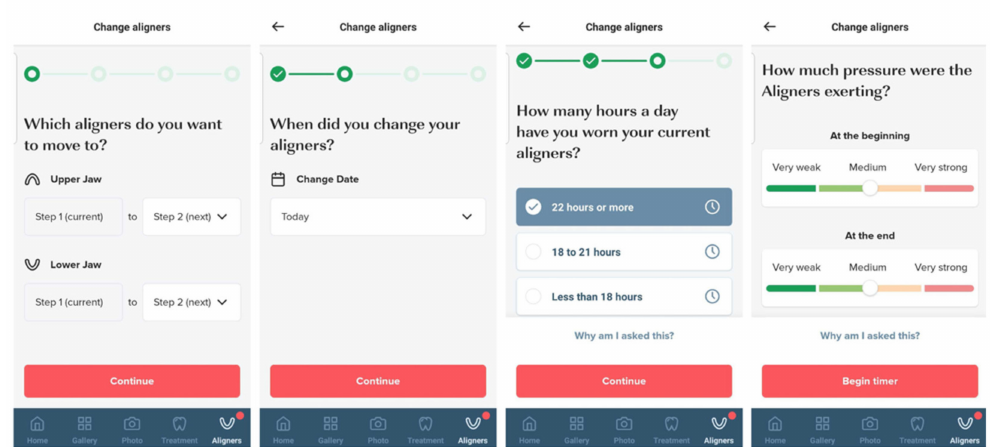
Figure 1. The PlusDental app-based questionnaire starting with the aligner check-in on the left.